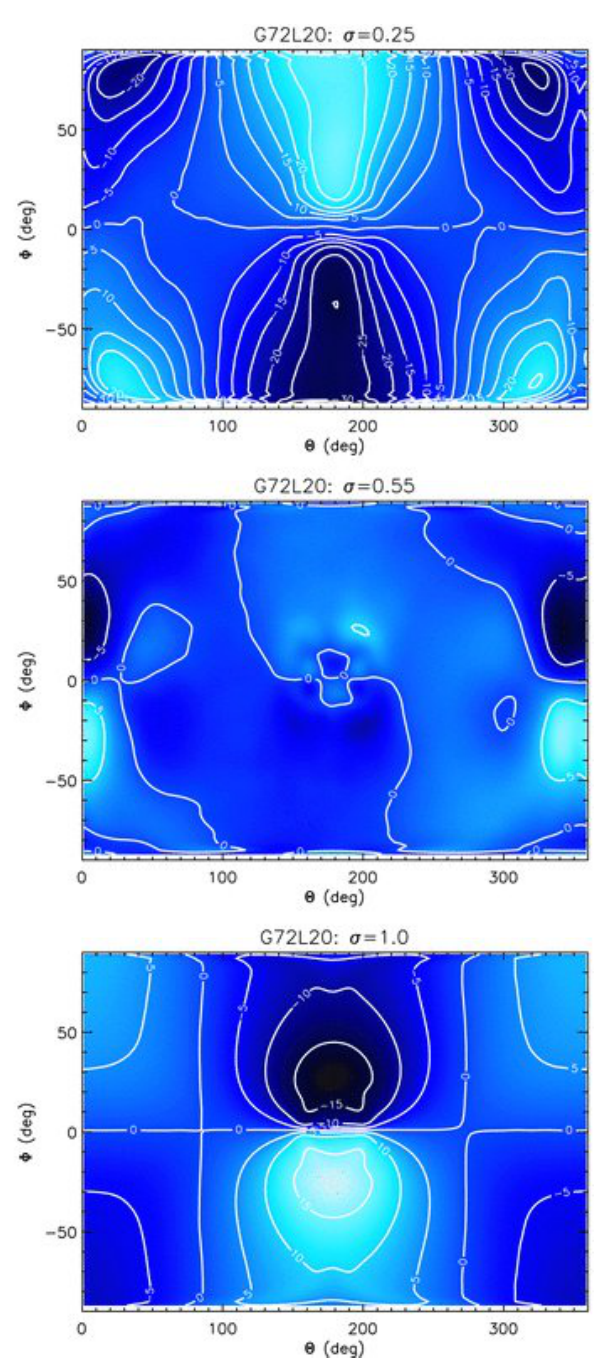
Figure 15. Figure reproduced from Heng et al. (2011b) of the re- Fig. 15. Figure reproduced from Heng et al. (2011b) of the results sults from the grid-based model of the TLE test case (reproduced from the grid–based model of the TLE test case (reproduced by per- with permission of Oxford University Press). Showing (from the mission of Oxford University Press). Showing (from the top panel top panel to the bottom panel) the temporally averaged meridional to the bottom panel ) the temporally averaged meridional wind at wind at σ = 0 . 225, 0 . 525 and 0 . σ = 0 . 225 , 0 . 525 and 0 . 975 .